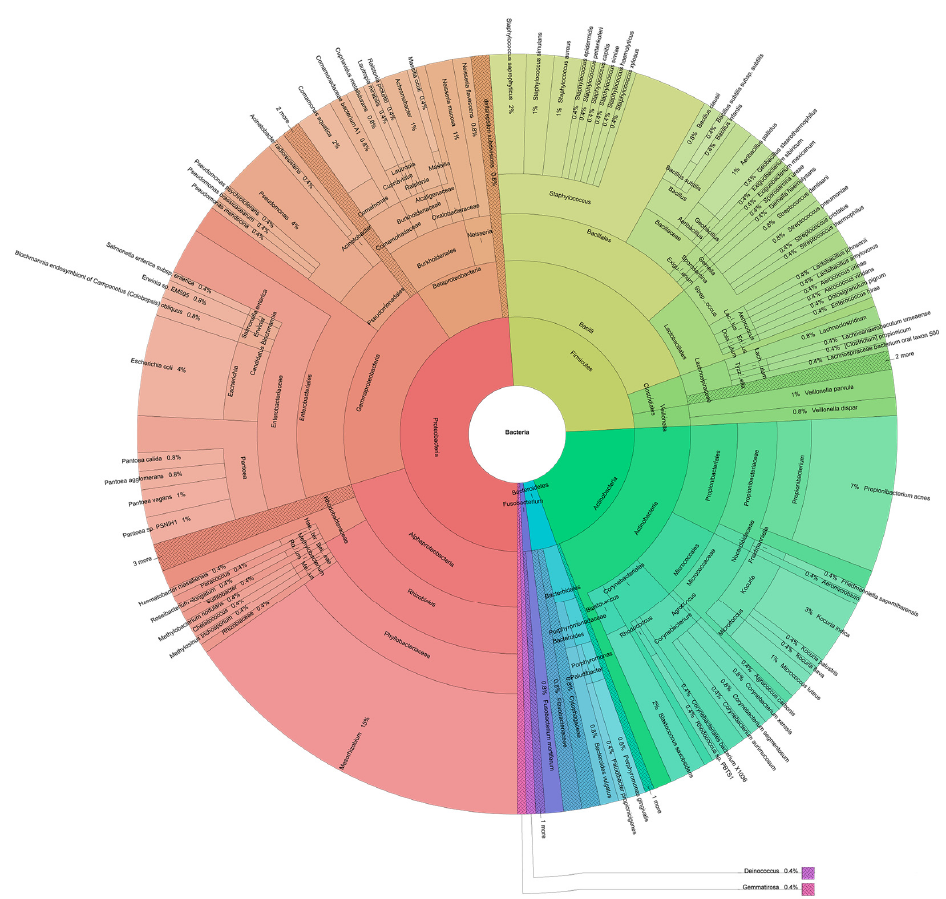
Figure 2. Kronas plot of the relative abundance of species detected in eDNA samples from 16S rDNA in the Quito Public Transport (QTP) during Mach 2022. Data set available at: https://usegalaxy.org.au/datasets/a6e389a98c2d1678a9b3a242082abea8/display/?preview= True&dataset=0&node=1&collapse=true&color=false&depth=8&font=10&key=true (accessed